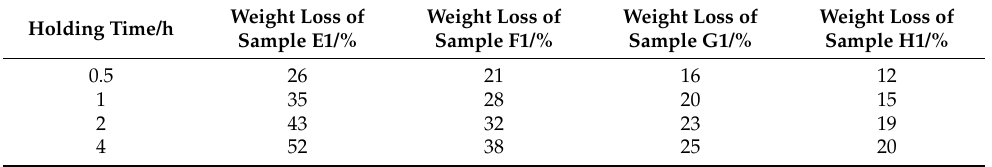
Table 1. Weight loss of sample 1 group under different holding times at 450 ◦ C. Holding